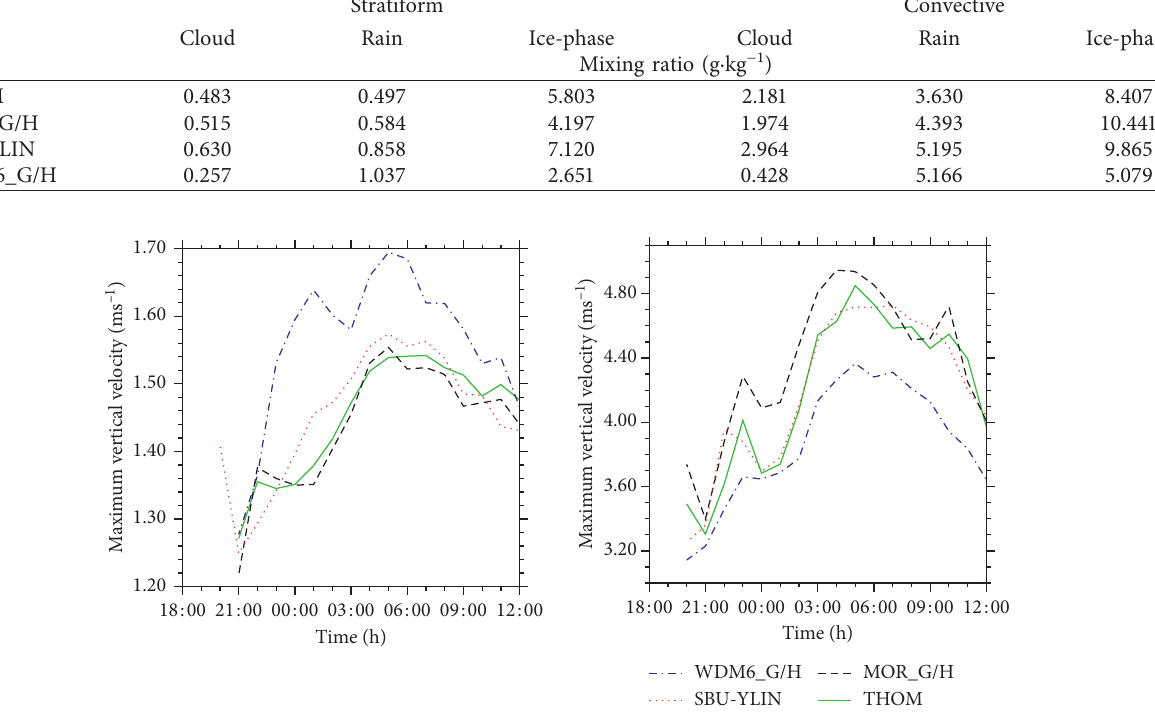
Table 3: Temporally and domain-averaged integrated vertically mixing ratio of cloud, rain, and ice-phase hydrometeors (sum of ice, snow, and graupel) of the four microphysical schemes over stratiform and convective